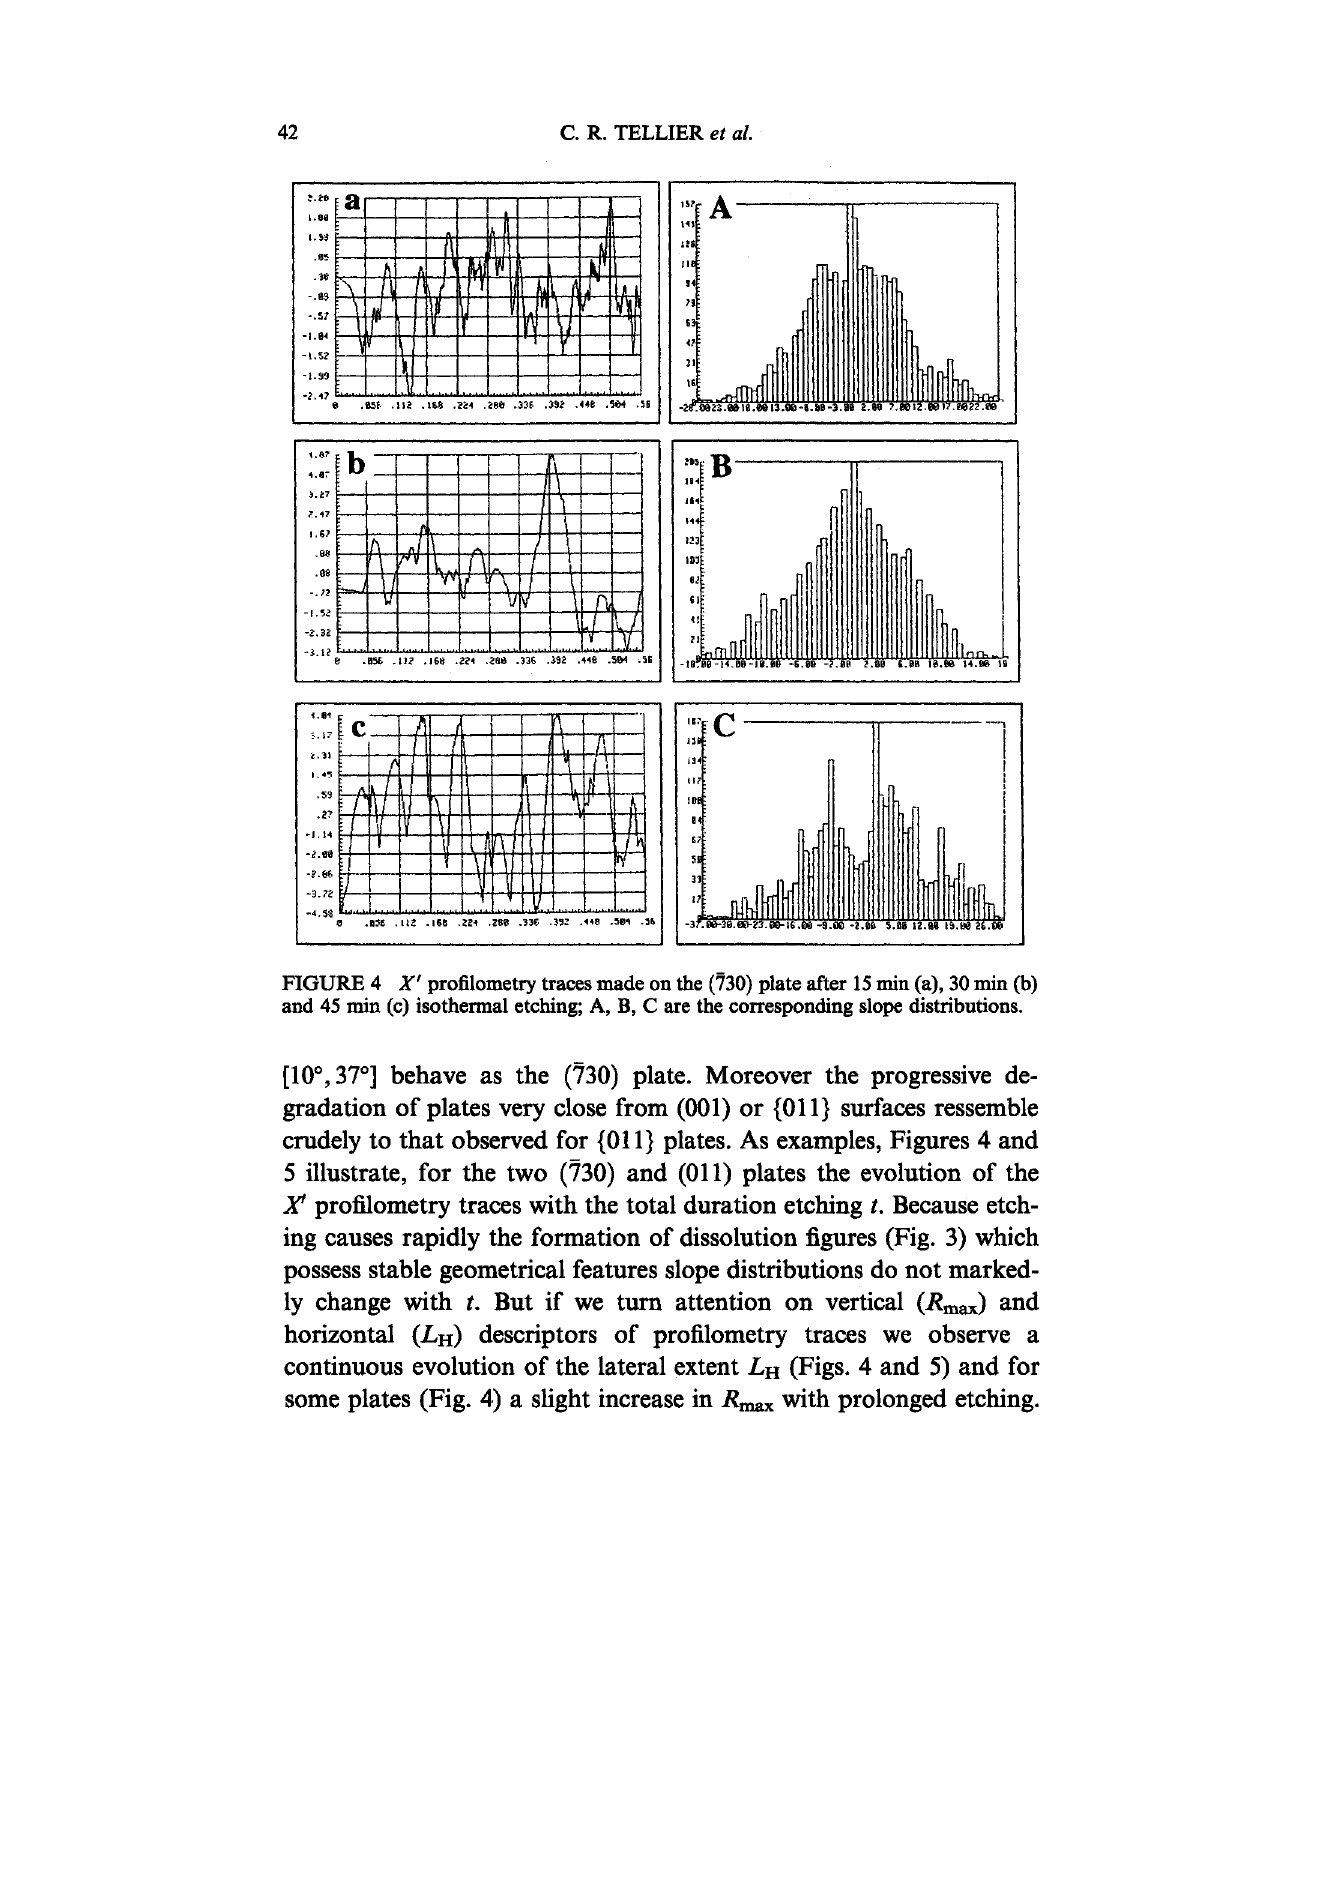
FIGURE 4 X’ profilometry traces made on the (30) plate after 15 min (a), 30 min (b) and 45 min (c) isothermal etching; A, B, C are the corresponding slope